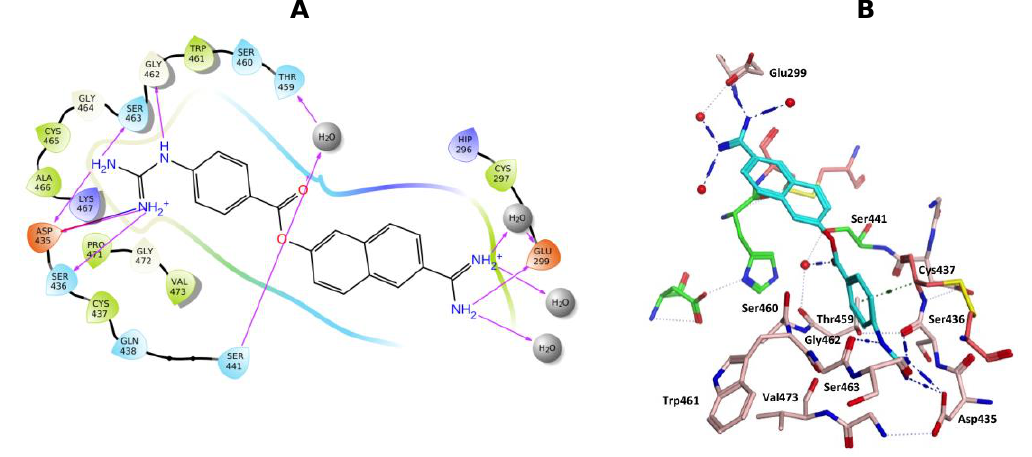
Figure 9. ( A ) 2D Ligand interactions and ( B ) 3D visualization of nafamostat (cyan).